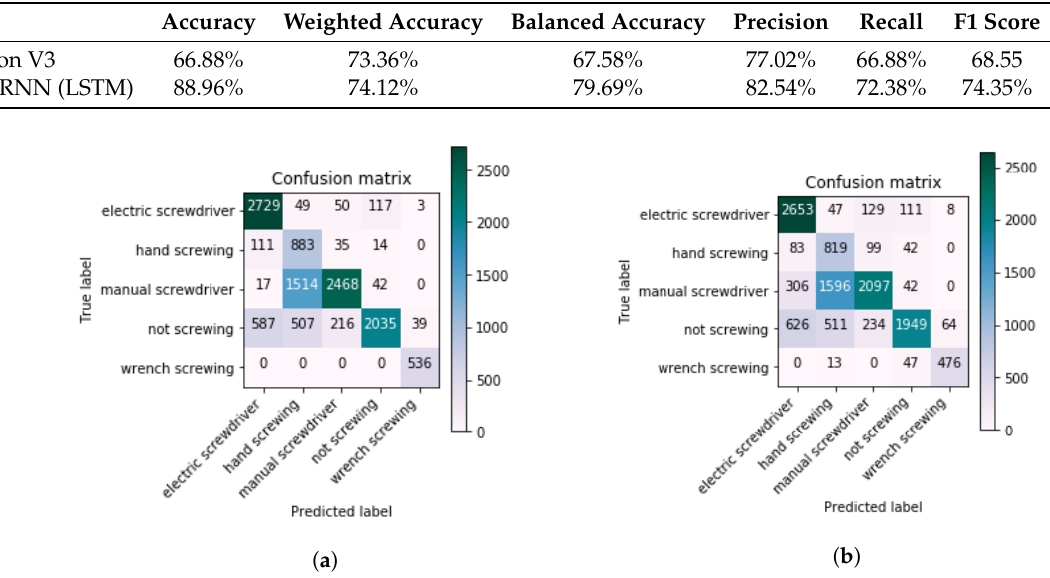
Table 3. Inception-V3 model accuracy results on the five classes.